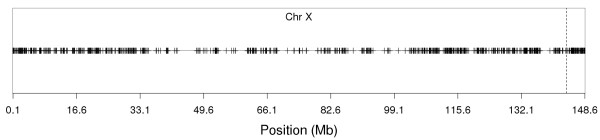
Distribution of SNPs across Chr X. The dashed line depicts the boundary between the X-specific and the pseudo-autosomal regions.